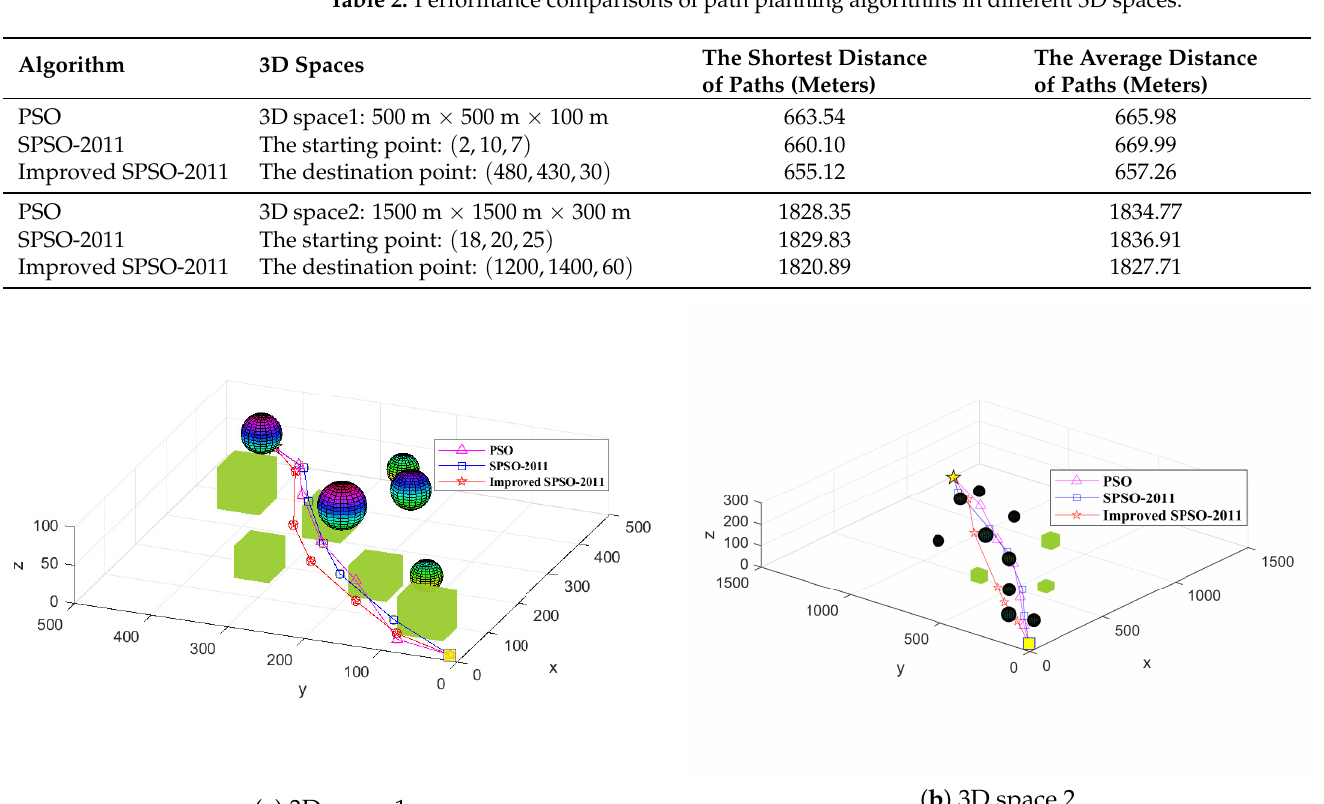
Figure 4. The fitness function curves of three path planning algorithms in different 3D spaces. Table 2. Performance comparisons of path planning algorithms in different 3D spaces.